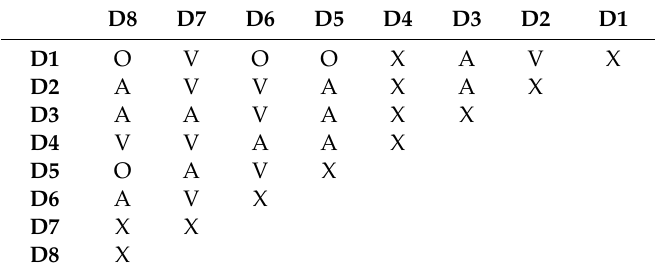
Table 4. Structural self-interaction matrix (SSIM) of the drivers of OSC.